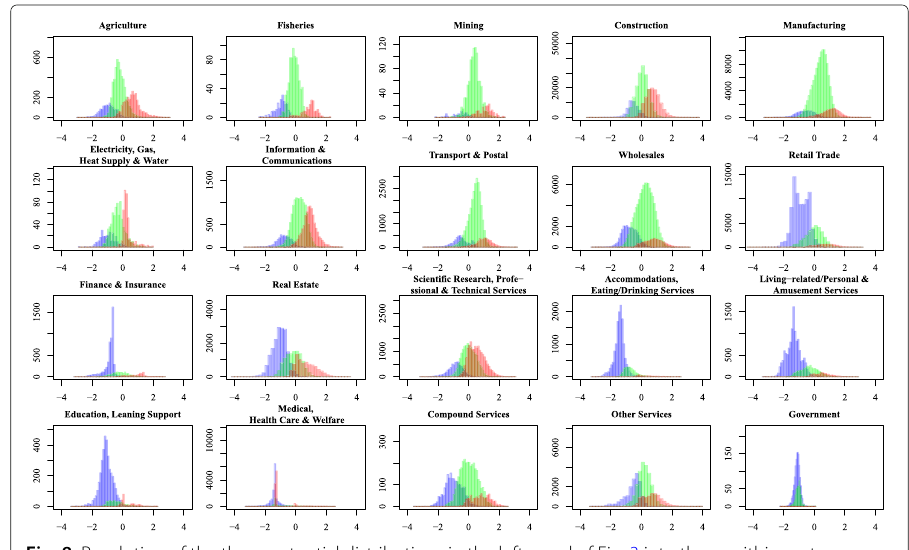
Fig. 8 Resolution of the three potential distributions in the left panel of Fig. 3 into those within sectors